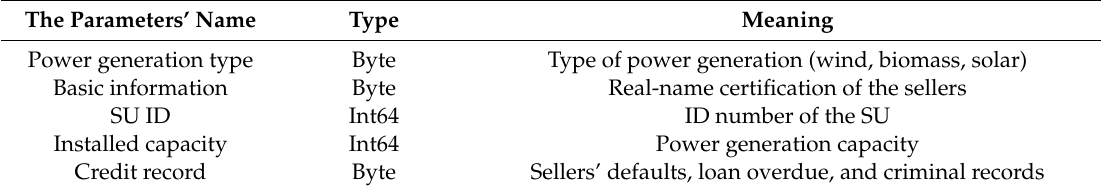
Table 2. Basic elements of authentication unit chaincode for the SU.